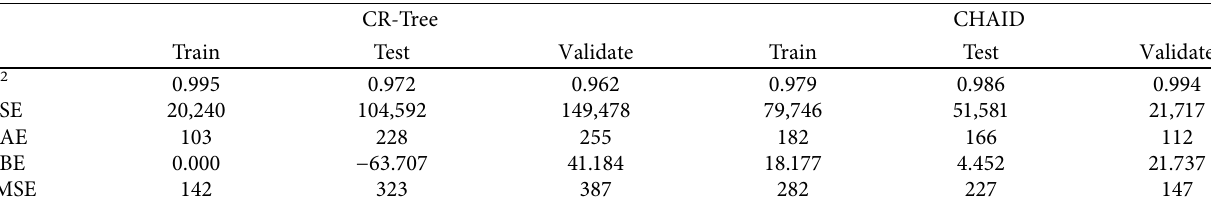
Table 6: CHAID and CR-Tree prediction results